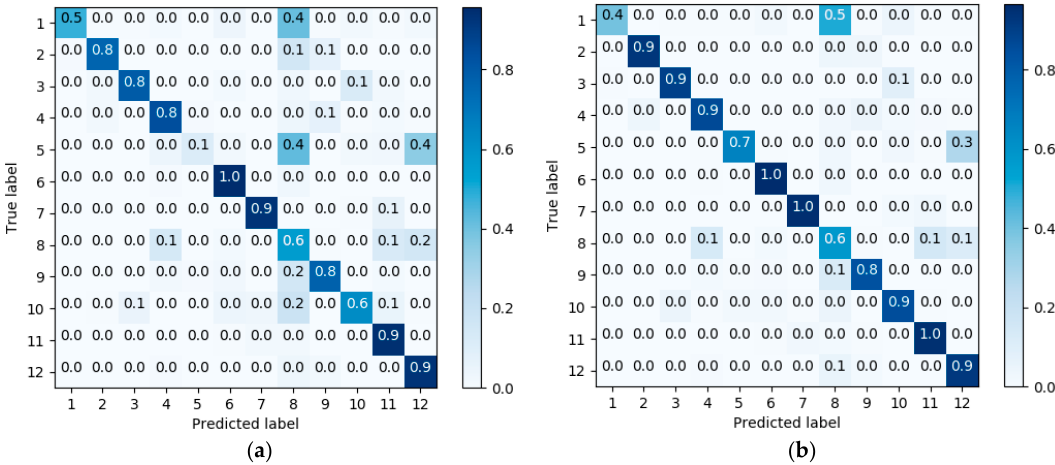
Figure 10. Confusion matrices for Merced using: ( a ) L ce loss, and ( b ) the total loss L = L ce + L h + L o .